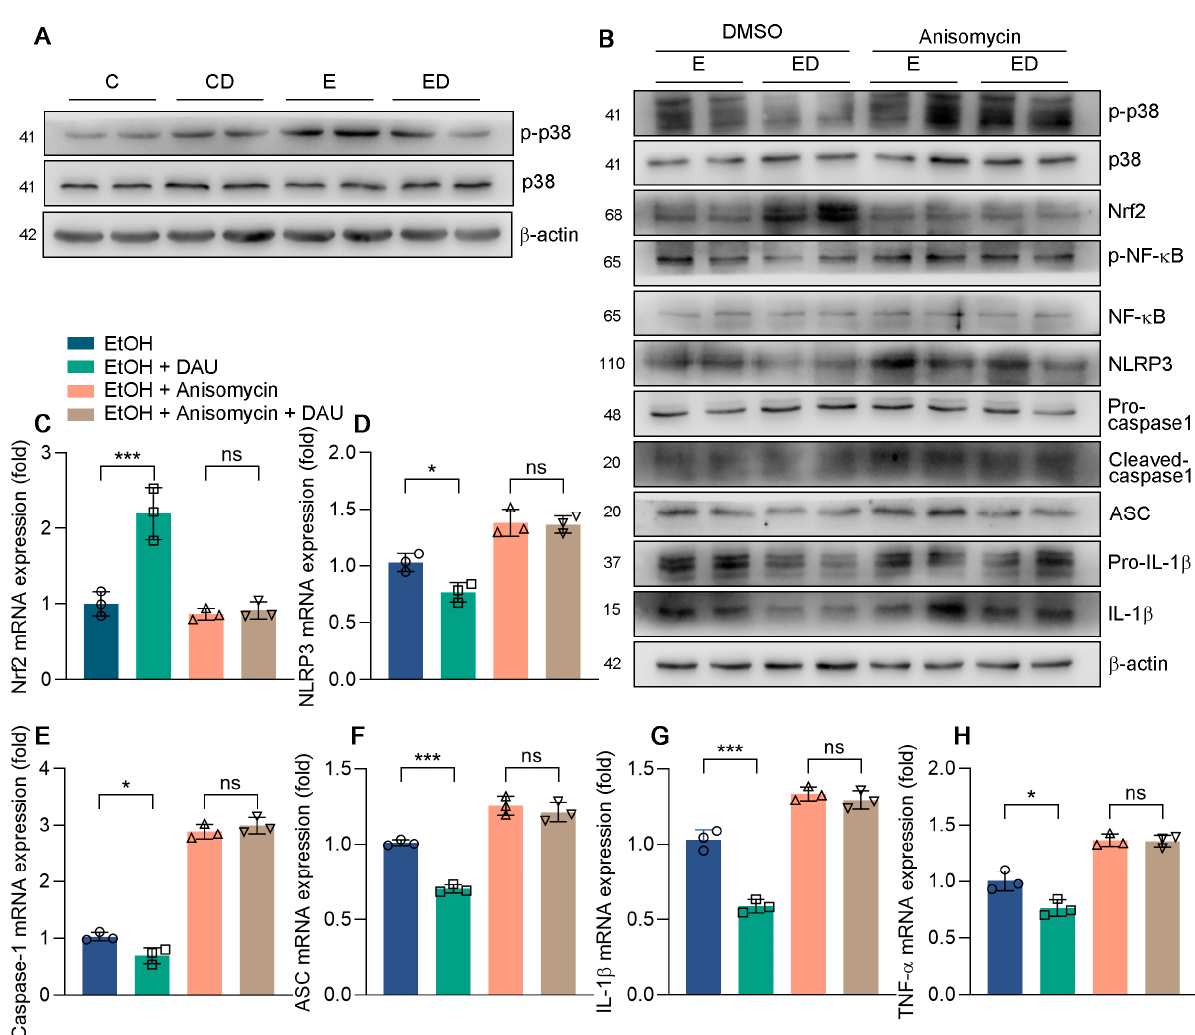
Figure 7. The effect of anisomycin in DAU ameliorated liver inflammation induced by alco- hol. ( A , B ) Protein expression of p − p38, p38, p − STAT3, STAT3, p − NF − κ B, NF − κ B, NLRP3, pro − caspase − 1, cleaved − caspase1, ASC, pro − IL − 1 β and IL − 1 β in HepG2. ( C – H ) mRNA ex- pression of Nrf2, NLRP3, caspase − 1, ASC, IL − 1 β and TNF − α in HepG2. Data are mean ± SD using one − way ANOVA ( n ≥ 3), * p < 0.05, *** p < 0.001, ns: not